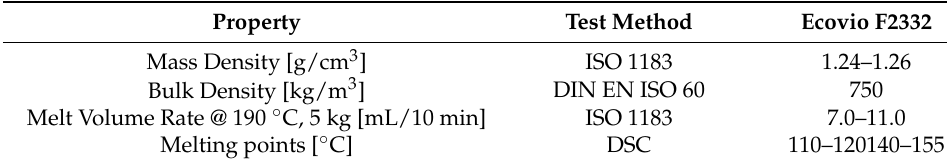
Table 1. Typical basic material properties of Ecovio